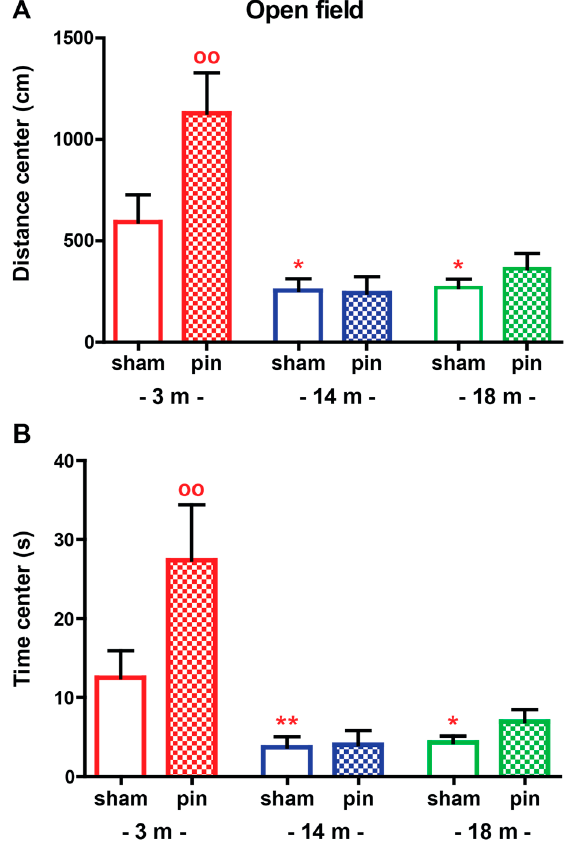
Figure 2. The effect of pin on distance traveled in the center (cm) ( A ) and time spent in the center ( B ) for 3-, 14- and 18-month-old rats tested in the open field test. Data are presented as mean ± S.E.M. * p = 0.013, * p = 0.048, 14- and 18-month-old rats, respectively, compared to 3-month-old rats; 3-month-old pin rats compared to matched sham rats ( A ); ** p = 0.003 and * p = 0.026, 14- and 18-month-old rats, respectively, compared to 3-month-old rats; oo p = 0.002 3-month-old pin com- pared to matched sham group ( B ). 3-month-old rats—red; 14-month-old rats—blue; 18-month-old rats—green.